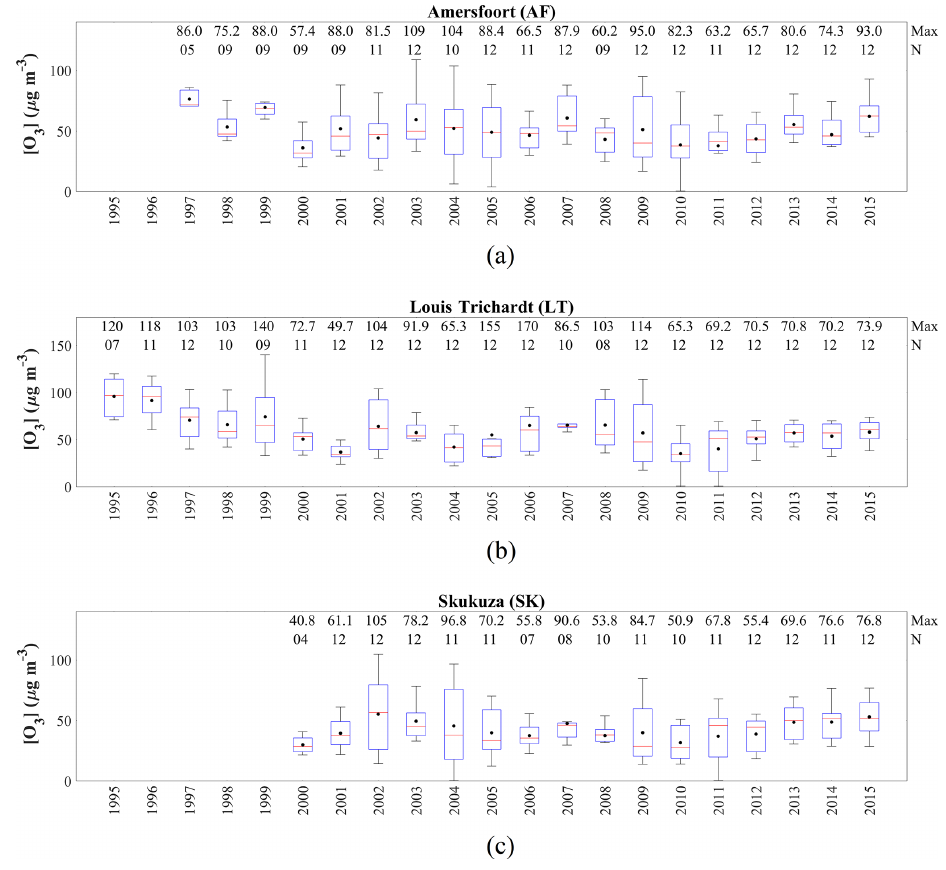
Figure 8. Annual O 3 concentrations at (a) AF, (b) LT and (c) SK. The red line of each box represents the median; the top and bottom edges of the box represent the 25th and 75th percentiles, respectively; the whiskers are ± 2 . 7 σ (99.3% coverage if the data have a normal distribution); and the black dots represent the averages. The maximum concentrations and the number of measurements ( N ) are presented at the